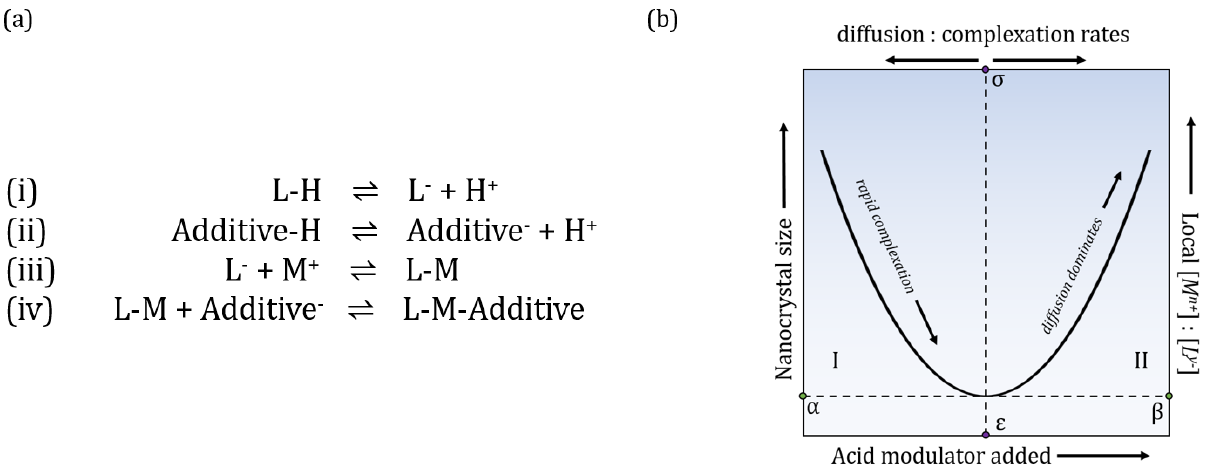
Figure 1. ( a ) Chemical equilibria controlling crystal growth and termination; deprotonation of linker (i) and additives (ii), complexation (iii) between metal ions and linkers = growth phase, (iv) competition between linker and additive for coordination sites on metal ions = termination phase. ( b ) Re- lationship between nanocrystal size, local metal-linker ratios, amount of modulator added and dif- fusion and complexation rates can be schematically represented in a seesaw model, with Regime I on the left and Regime II on the right side.